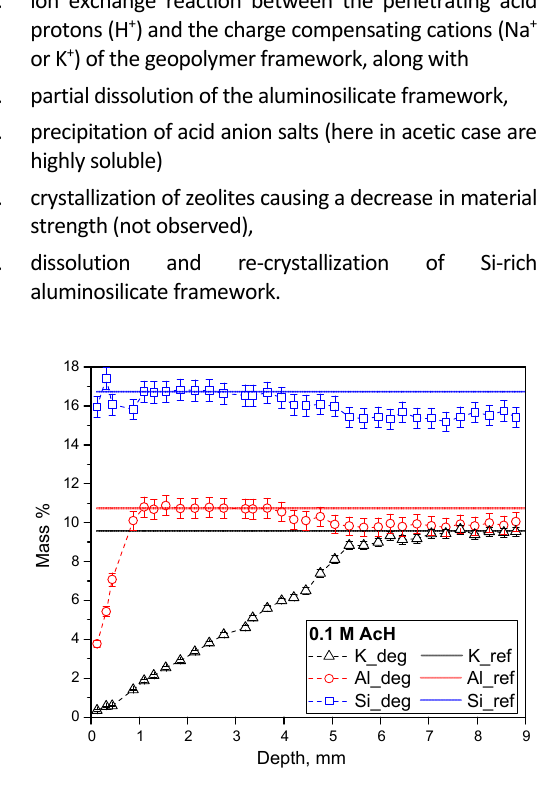
Figure 10. Degradation profile after leaching in the acetic acid (AcH): semi ‐ quantitative chemical composition as a function of degradation depth, obtained as a statistical analysis of EDS mappings (Fig. 7) taken per various depth ranges (indicated on x ‐